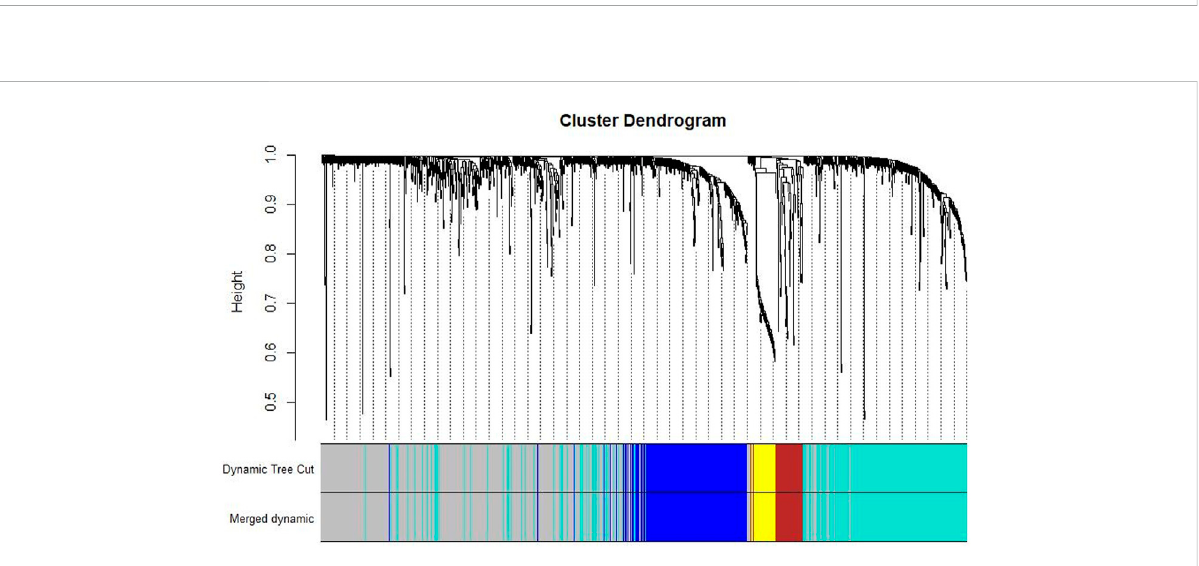
FIGURE 2 Determination of soft thresholds and testing of scale-free networks. (A) Correlation between log (K) and log [P (k)] corresponding to different soft thresholds. The higher the coef fi cient, the more the network conforms to the distribution of the scale-free network. (B) Mean value of gene neighbor coef fi cients in the gene network corresponding to different soft thresholds, which re fl ects the average connectivity level of the network. (C) Distributionoftheconnectivityofeachnodeinthenetwork. (D) Scatterplotoflog(K)vs.log[P(k)]andthelinearregressionresultsshowthat the correlation coef fi cient is